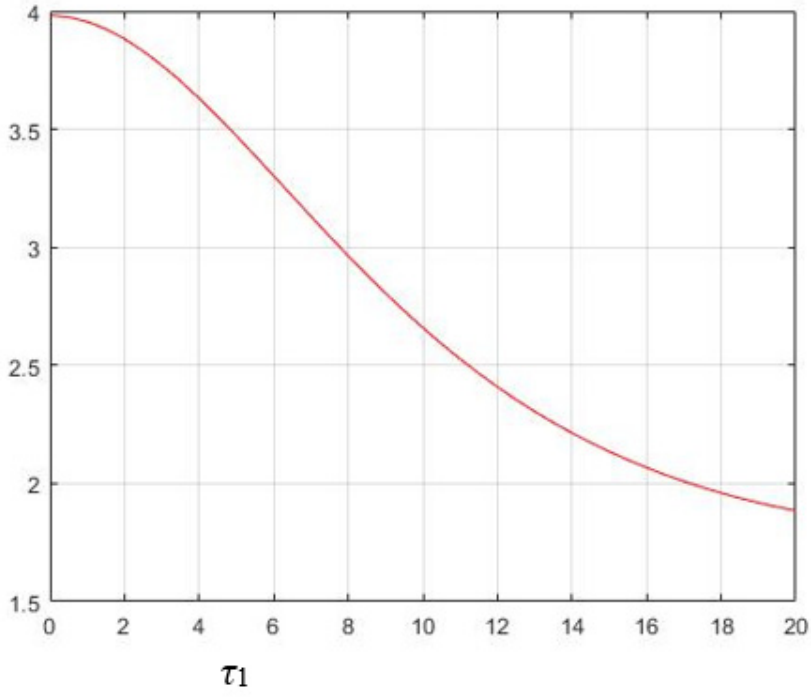
= τ Figure 4. The plot of C 1 ( τ 1 ) against threshold τ 1 , and τ ∗ 2 . 1 τ τ τ= * ( ) C τ Secondly, we consider the influences of repair threshold τ 2 on the results under the 1 2 Figure 4. The plot of 1 1 against threshold 1 , and . policy N τ . Let λ = 80, η = 15, a = 1.05, b = 0.95, p = 0.45, q = 0.55, c f = 10, c d = 50, 1 ) for different values of τ c r = 1800. The optimal τ ∗ and C 1 ( τ ∗ 2 are tabulated in Table 2. 1 1 According to Table 2, when τ 2 is small, optimal policy τ ∗ equals τ 2 , which can be interpreted 1 by the fact that C 1 ( τ 1 ) decreases on the interval [ 0, τ 2 ] ; when τ 2 is large enough, with the increase of τ 2 , optimal policy τ ∗ and the corresponding long-run average cost rate increase 1 gradually. The above analysis results are in line with our